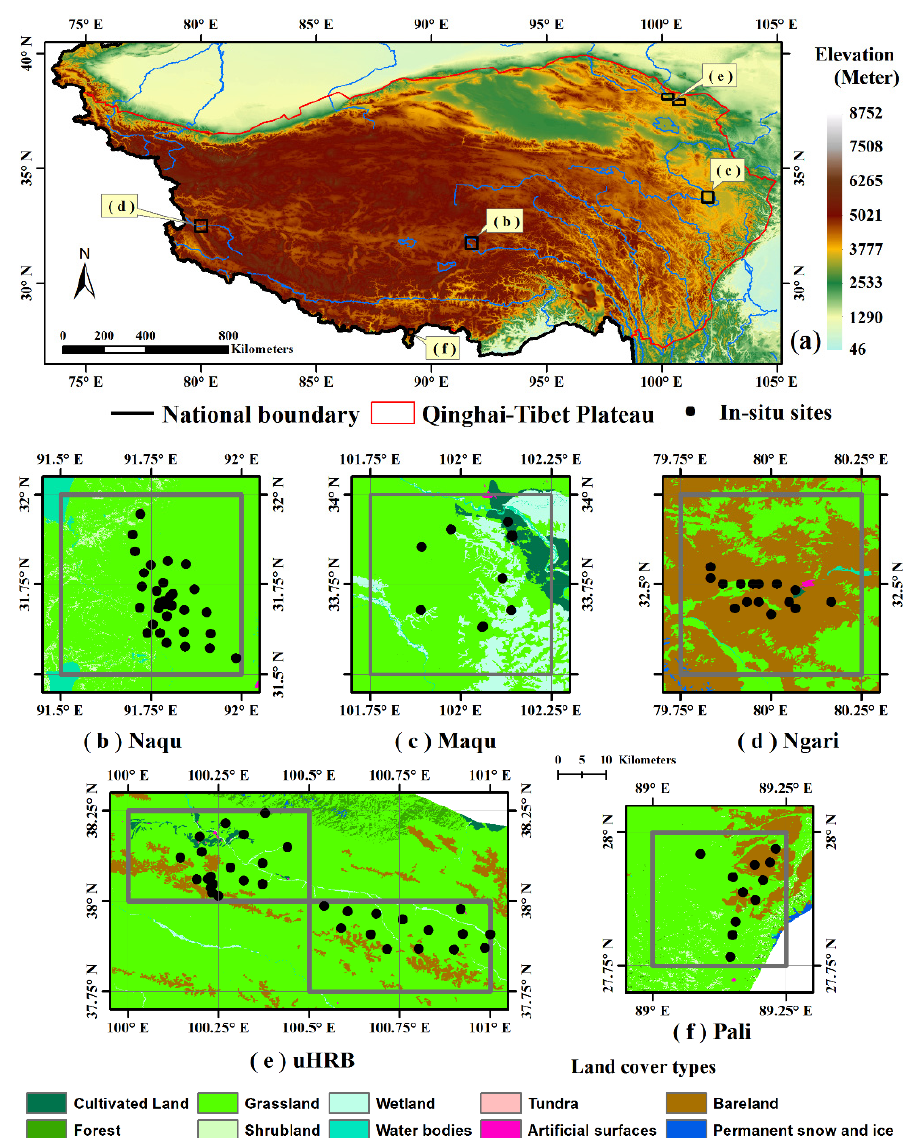
Figure 1. The locations of the sites within the Qinghai–Tibet plateau (QTP) in China.